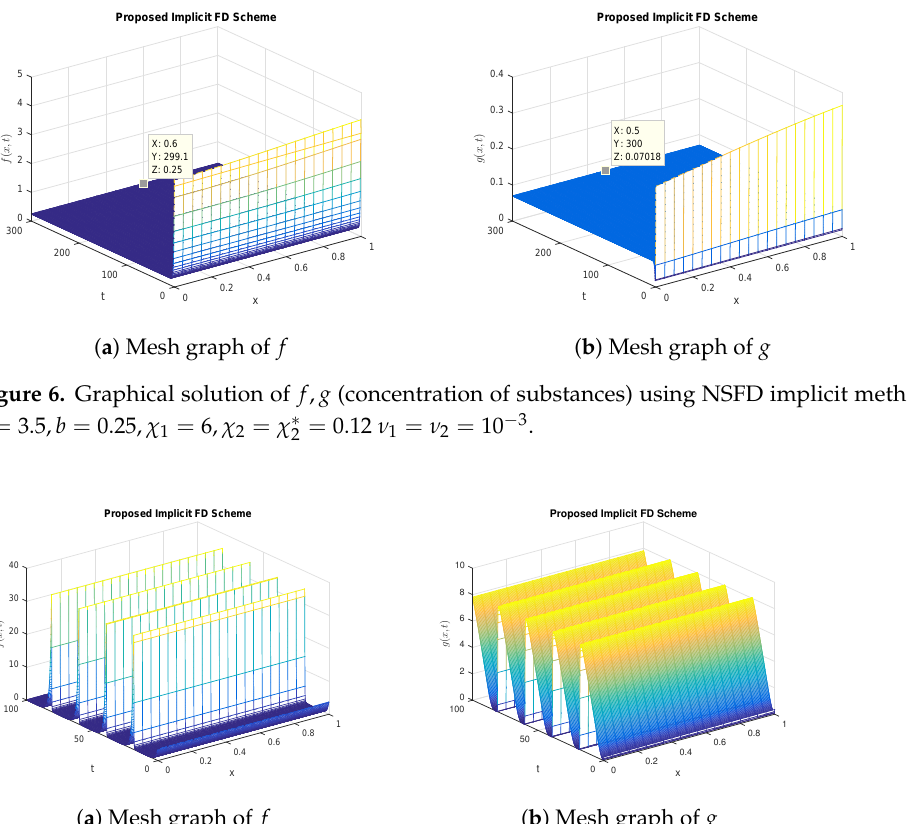
= 0.04 ν = ν = 10 − 3 2 1 2